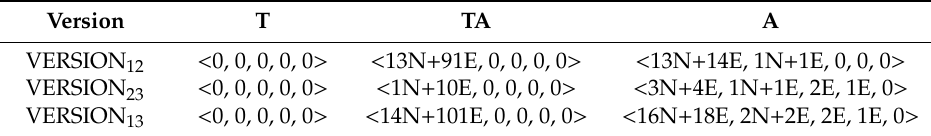
Table 2. Values of criteria Npl and Iz for development